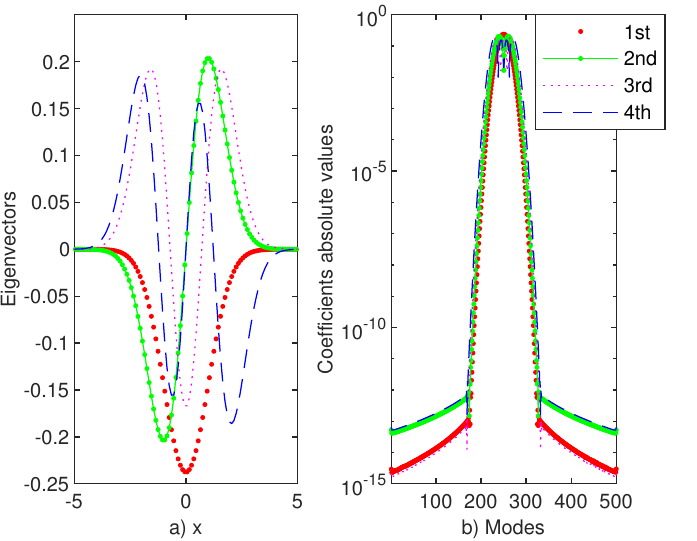
Figure 12. ( a ) Zoom in the first four eigenvectors computed by SiC for the Schrödinger eigenproblems (1)–(11) with potential (10). ( b ) The sinc coefficients for these vectors. We mention that the figure in panel ( a ) has the same legend as that in panel b).